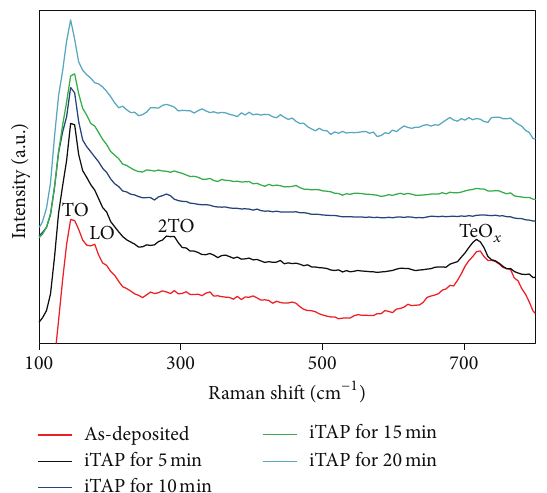
Figure 4: Raman spectra of five samples treated with different iTAP durations at 450 ∘ C. Peaks corresponding to the CdTe TO, LO, and 2TO modes as well as a signature peak of TeO 𝑥 can be observed at Raman shifts of 141, 169, 292, and 730 cm −1 ,